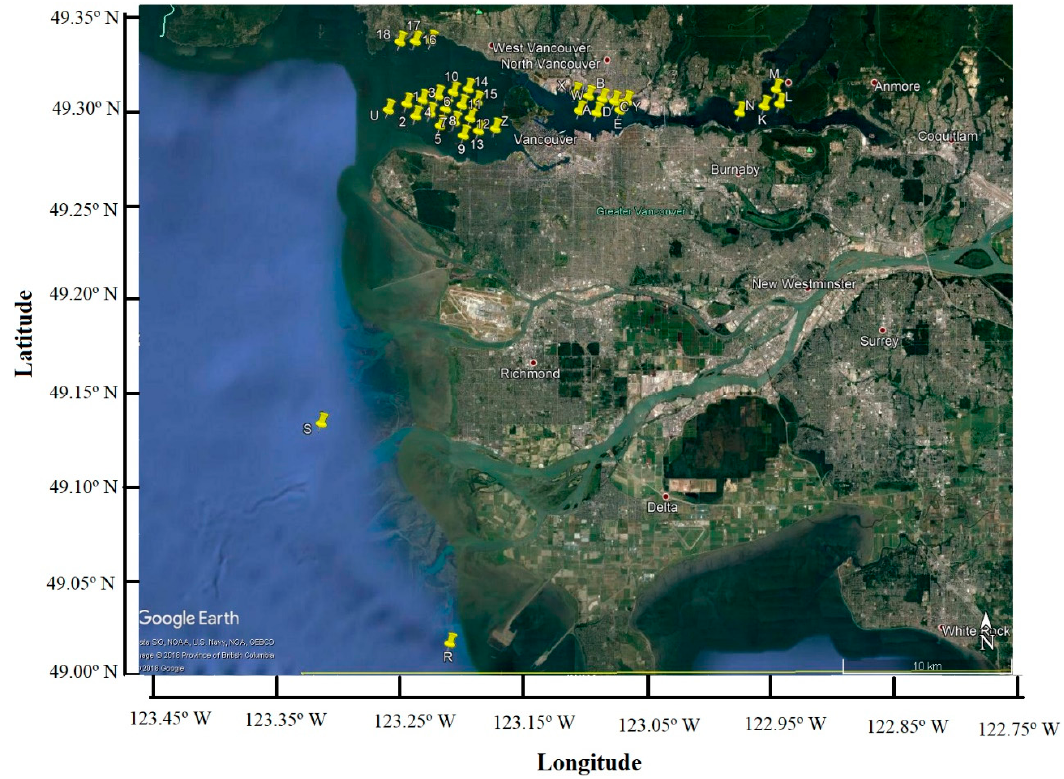
Figure 1. Anchorages’ position at the Port of Metro Vancouver (PMV). Modified based on [5].